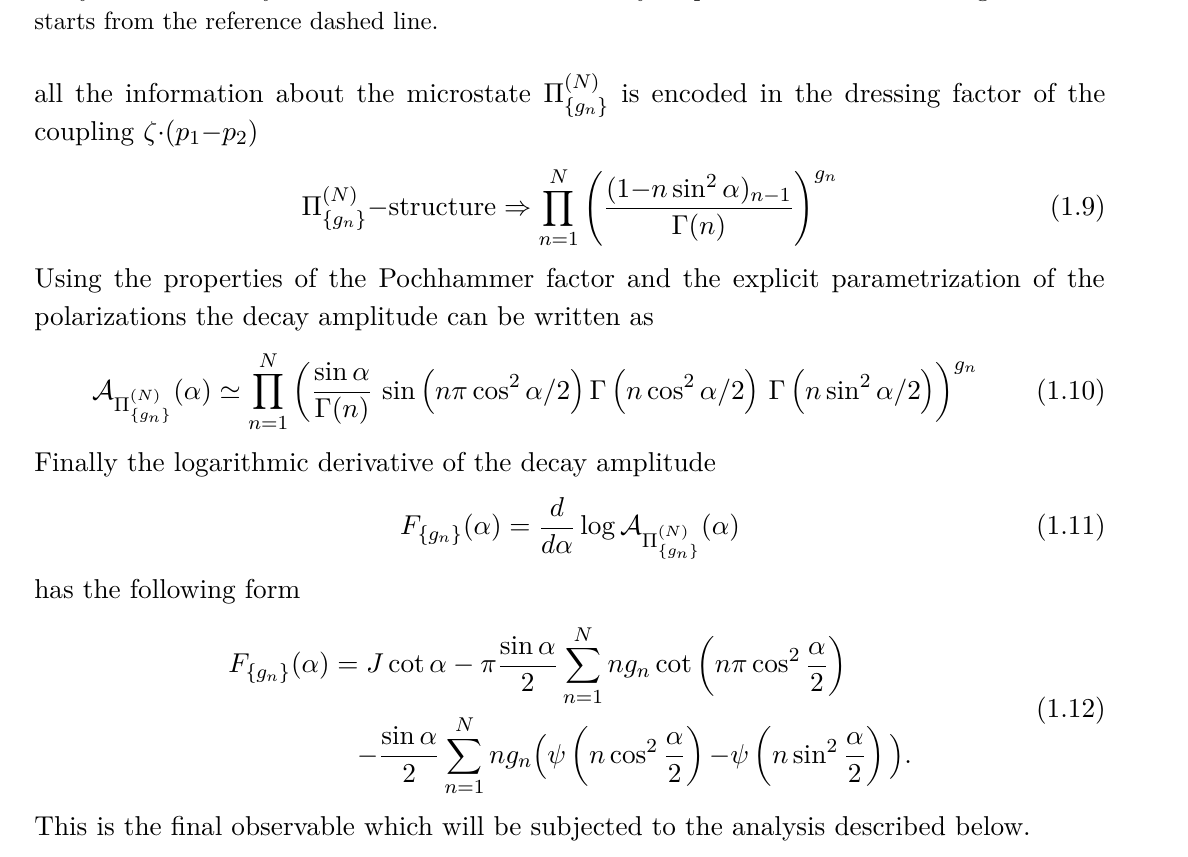
Figure 3 . Picture of the decay amplitude where a representative microstate Π ( N ) tachyons T . The only kinematical freedom of the decay amplitude is the emission angle α which starts from the reference dashed